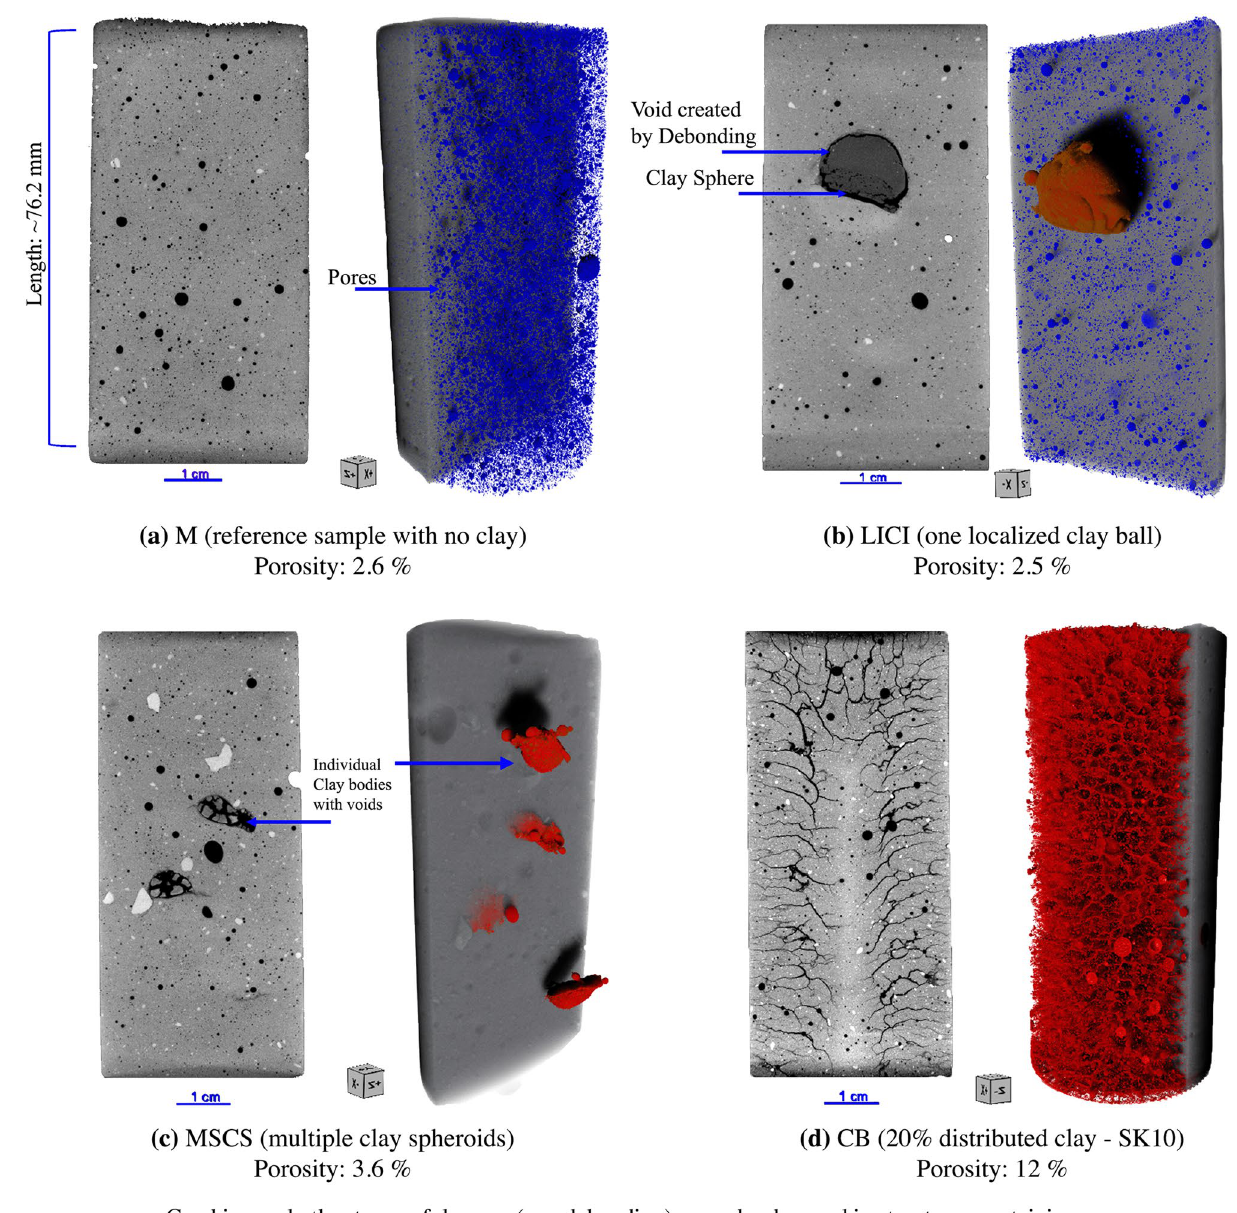
Figure 1. 2D images from the center of the sample along the vertical axis, and 3D visualizations of the interior for the geo-architected samples after 6 full days of dehydration. The pixel edge length resolution is ∼ 40 µ m and the average radius is 19.05 mm. All samples contain non-connected pores (displayed in blue) which are shown only for the reference sample ( a ) and the LICI sample ( b ). Clay inclusions are displayed in brown. All cracks are displayed in red, as shown for the MSCS sample ( c ) and the CB-SK10 sample ( d ). Cracks are only observed in samples containing localized or distributed clay which can result in a 40% reduction in material strength (a comparison between the reference and the CB-SK10 sample). Data are visualized with Dragonfly Pro software, Version 2020.2 for [Windows] from ORS 13